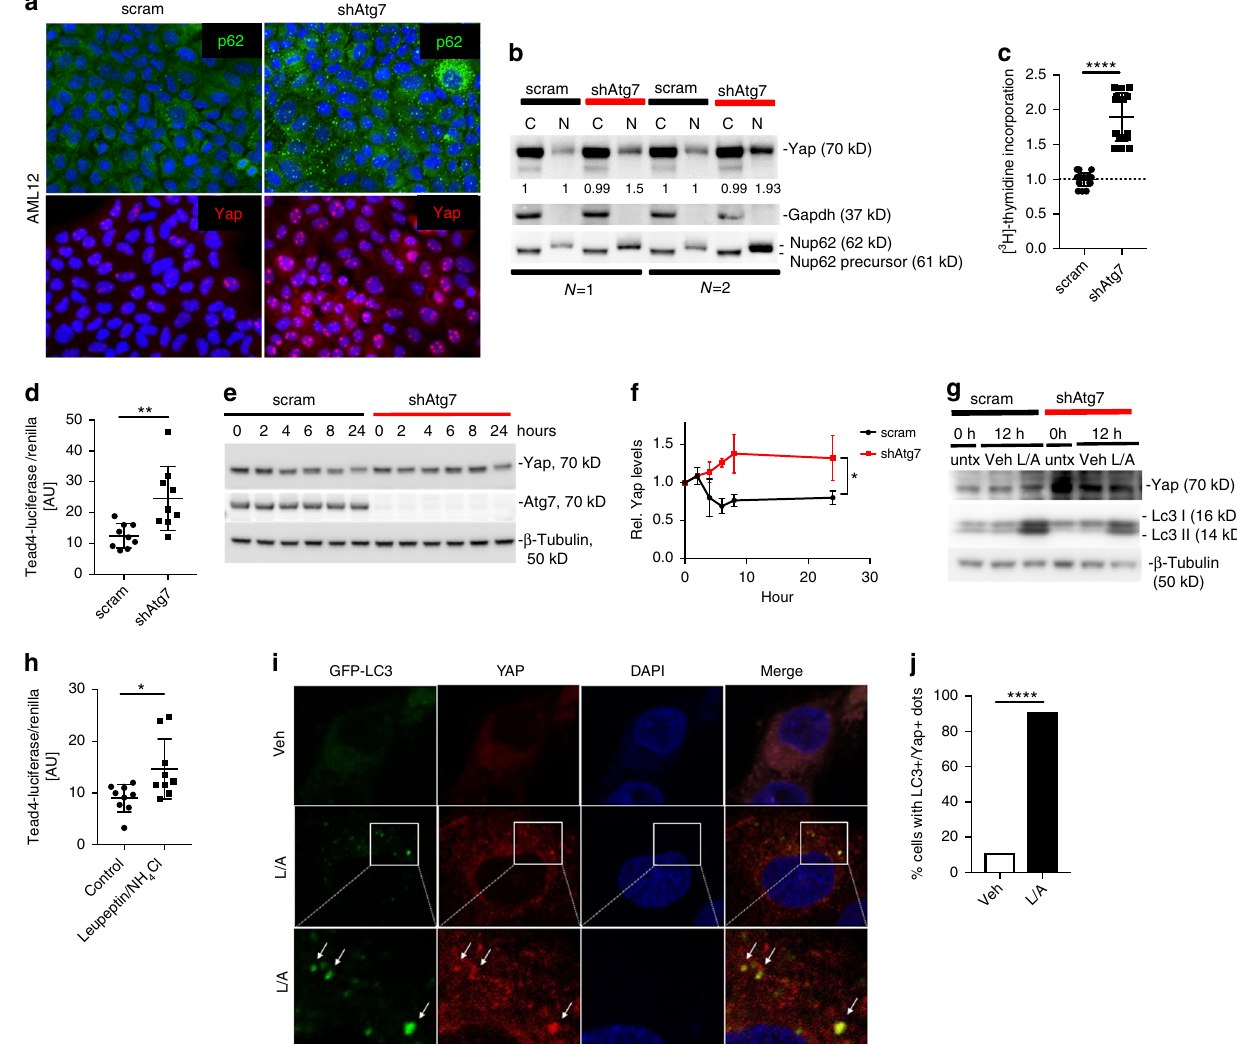
Fig. 2 Yap is degraded by autophagy. a Immuno fl uorescence analysis of scram- and shAtg7-AML12-infected cells for p62/Sqstm1 and Yap. b Subcellular fractionation of cytoplasmic (C) and nuclear fractions (N) from scram- and shAtg7-infected AML12 cells. Immunoblotting for Yap, Gapdh, Nup62. Results representative of four independent experiments. c [ 3 H]-Thymidine incorporation assay in scram- and shAtg7-AML12 cells. Mean ± SD. Data from two independent experiments and normalized to scram. Measurements in triplicates. **** P < 0.0001 by two tailed t -test. d Tead4-Luciferase assay of scram- and shAtg7-infected AML12 cells. Data represent three experiments. Mean ± SD. ** P < 0.005 as determined by two tailed t -test. e Cycloheximide chase assay of scram- and shAtg7-AML12 infected cells. Immunoblotting of whole cell lysates for Yap, Atg7 and β -Tubulin after cycloheximide incubation. f Densitometry analysis for Yap. Data normalized to time 0, mean ± SEM. CHX, cycloheximide. * P = 0.030 as determined by paired two tailed t -test. g Immunoblotting of cell lysates of scram- and shAtg7-AML12 infected cells incubated with Leupeptin/NH 4 Cl or vehicle only. Immunoblotting for Yap, Lc3 I, II and β -Tubulin. Untx, untreated; Veh, vehicle; L/A, Leupeptin/NH 4 Cl; h, hours. h Tead4-Luciferase assay of AML12 cells incubated with Leupeptin/ NH 4 Cl or vehicle. Data from three independent experiments. Mean ± SD, * P < 0.05 as determined by two tailed t -test. i Confocal immuno fl uorescence of THLE5B cells transfected with GFP-LC3 and incubated with Leupeptin/NH 4 Cl or vehicle, staining for YAP and with DAPI for nuclei. j Quantitative analysis of cells with LC3 + /YAP + dots. **** P < 0.0001 as determined by two tailed t